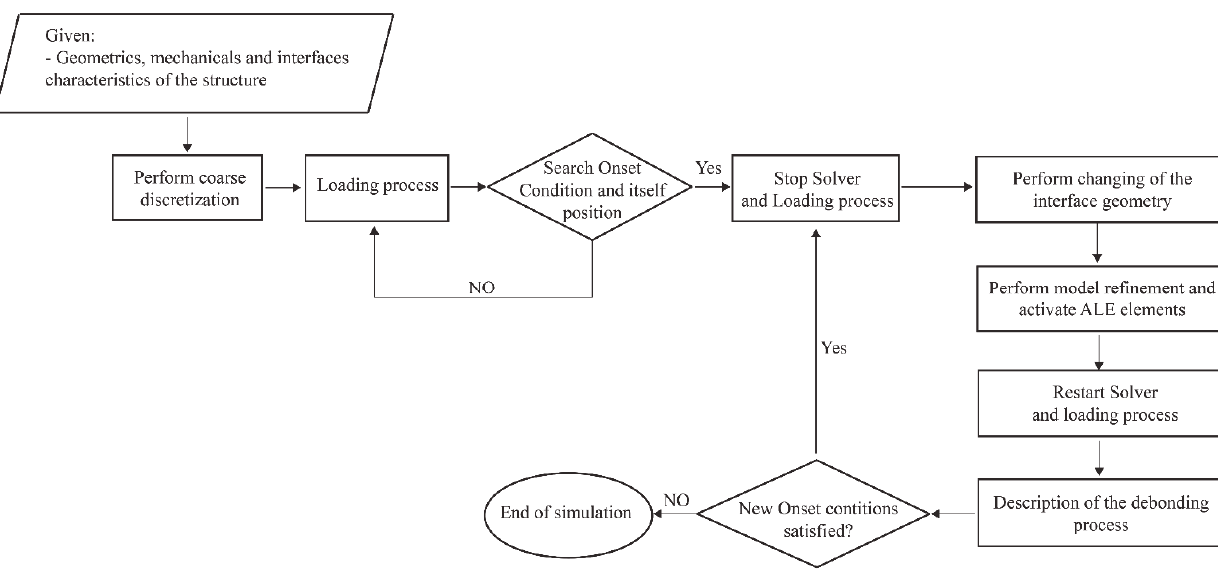
Figure 3: Schematic representation of the algorithm for layered structure, crack initiation and evolution.